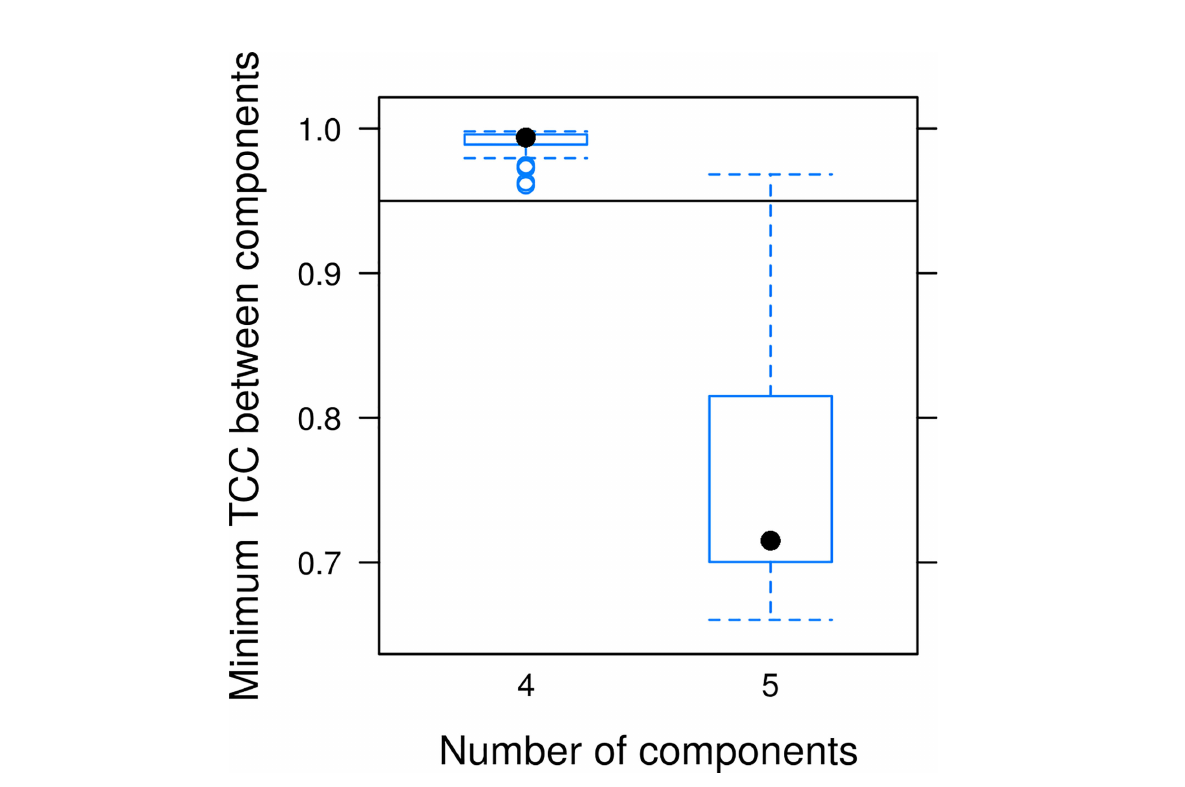
FIGURE 5 Split-half validation for the PARAFAC model. The dataset has been randomly shuf fl ed and split in halves 100 times; a PARAFAC decomposition was computed for every split. After reordering the components according to best match by ‘ TCC, the minimal TCC value among all pairs of emission and excitation components was taken for every pair of decompositions.